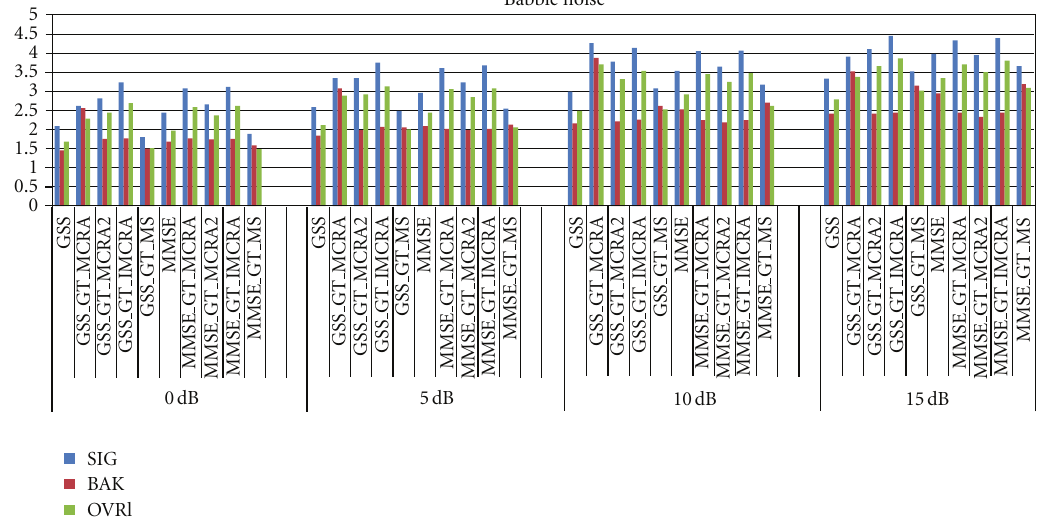
Figure 6: SIG-BAK-OVRL scores for proposed speech enhancement with the gammachirp decomposition compared to the GSS and the MMSE at di ff erent SNR input for babble noise.